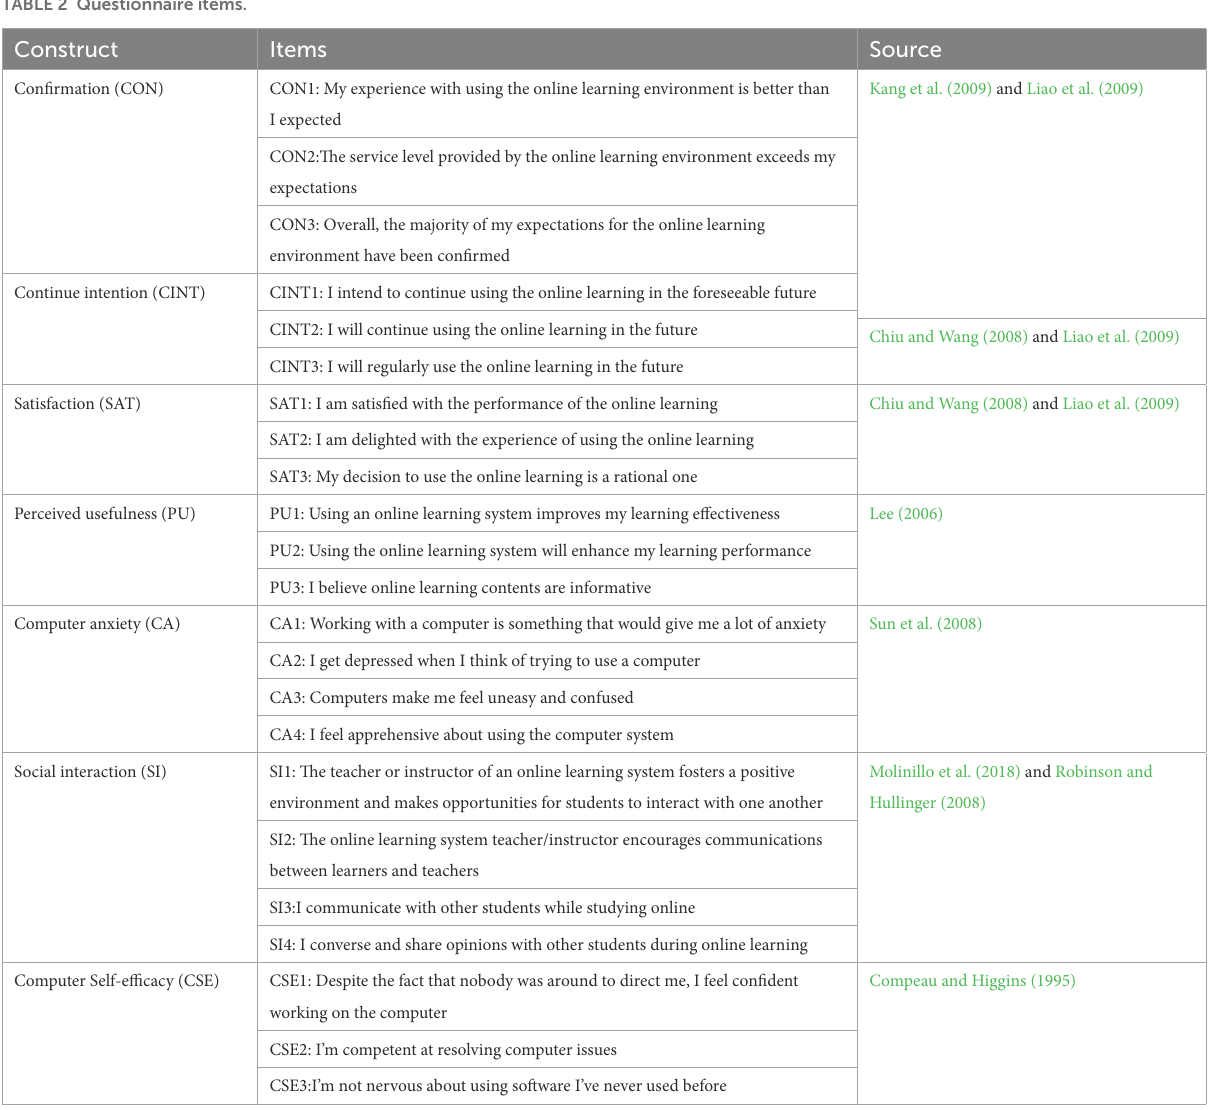
TABLE 2 Questionnaire